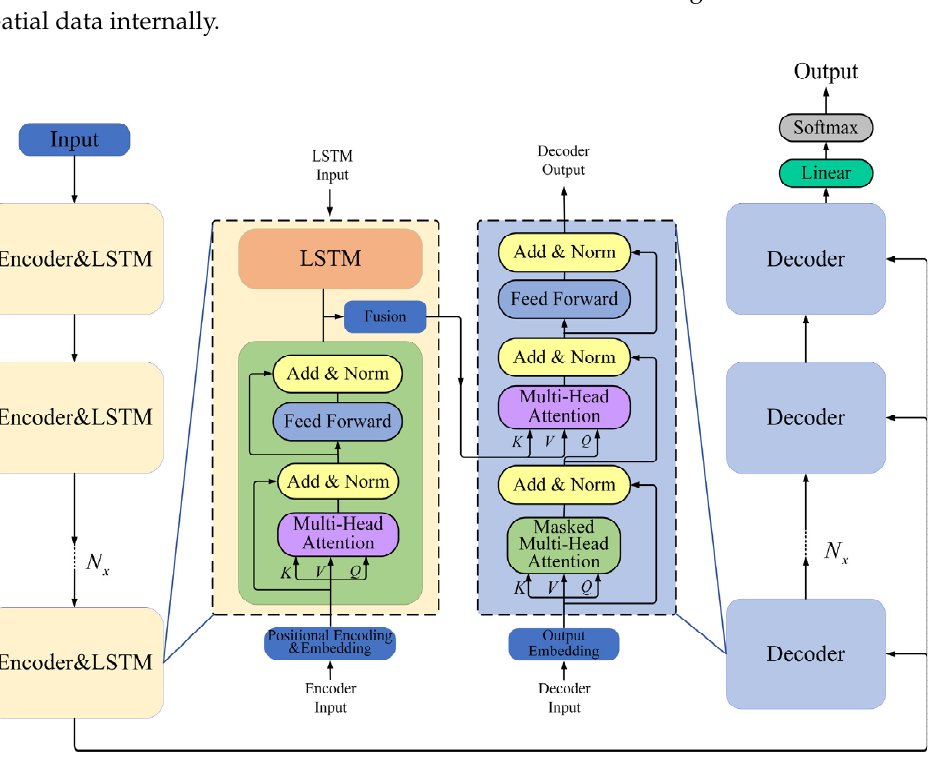
Figure 6. The Transformer Structure.